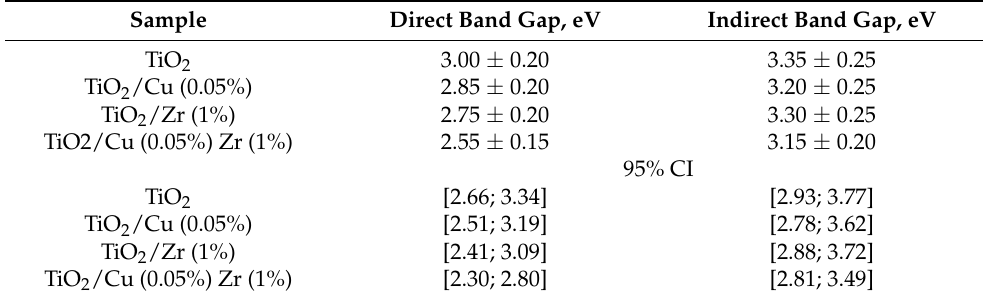
Table 1. Values of the direct and indirect band gaps and 95% CI of the unmodified and Cu-